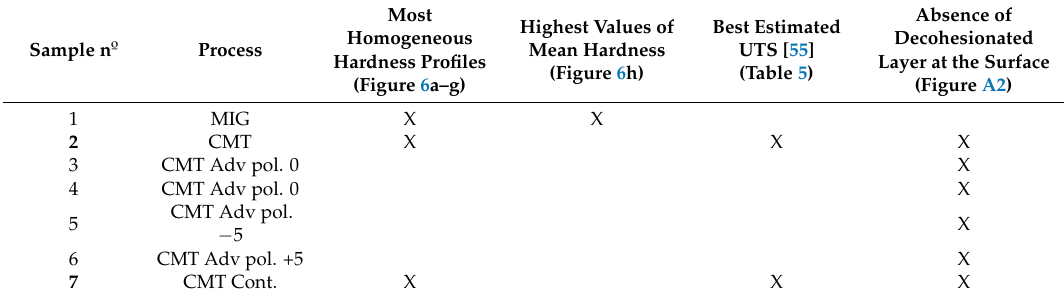
Table 8. Summary of the best process conditions according to homogeneous hardness profiles and mean values, the estimated ultimate tensile strengths (UTS) derived from hardness measurements, and the absence of the decohesionated layer at the surface found at microstructural level.